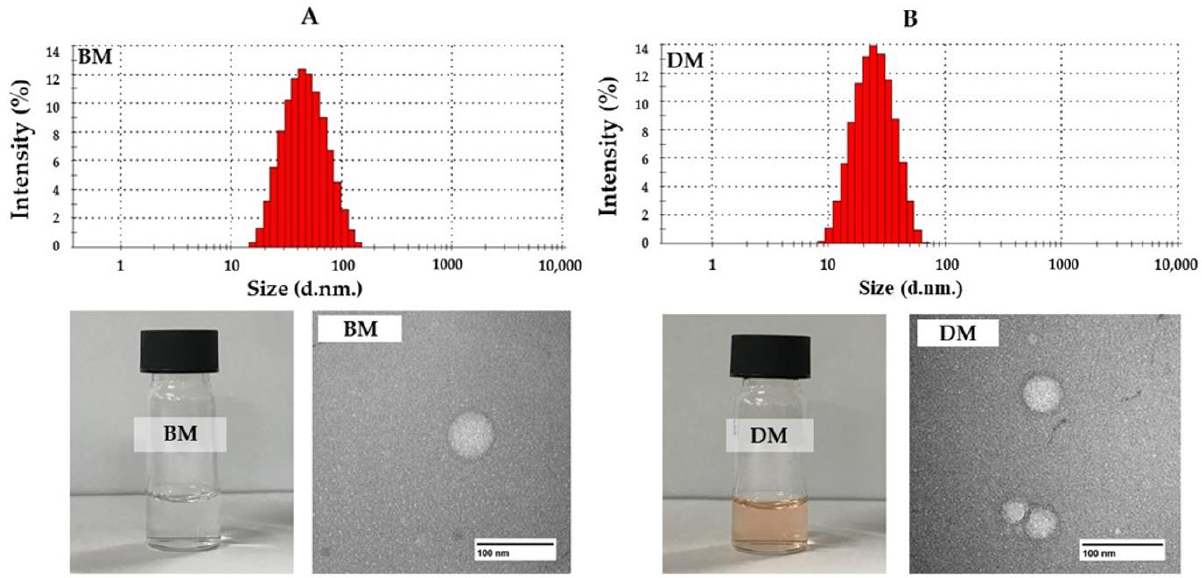
Figure 1. Physical appearance and particle size distribution histogram from DLS, and morphology from TEM of ( A ) blank micelles (BMs) and ( B ) Dox-micelles (DMs).